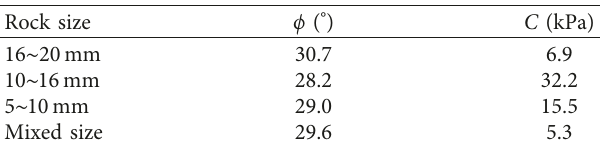
Figure 7: Curves of ( σ 1 − σ 3 ) ∼ ε under variable rock percentage or 5 ∼ 10mm size: (a) 200kPa confining pressure; (b) 400kPa confining pressure; (c) 800 kPa confining pressure; (d) 5 ∼ 10mm block size. Table 6: Strength index of different rock sizes according to the Mohr–Coulomb